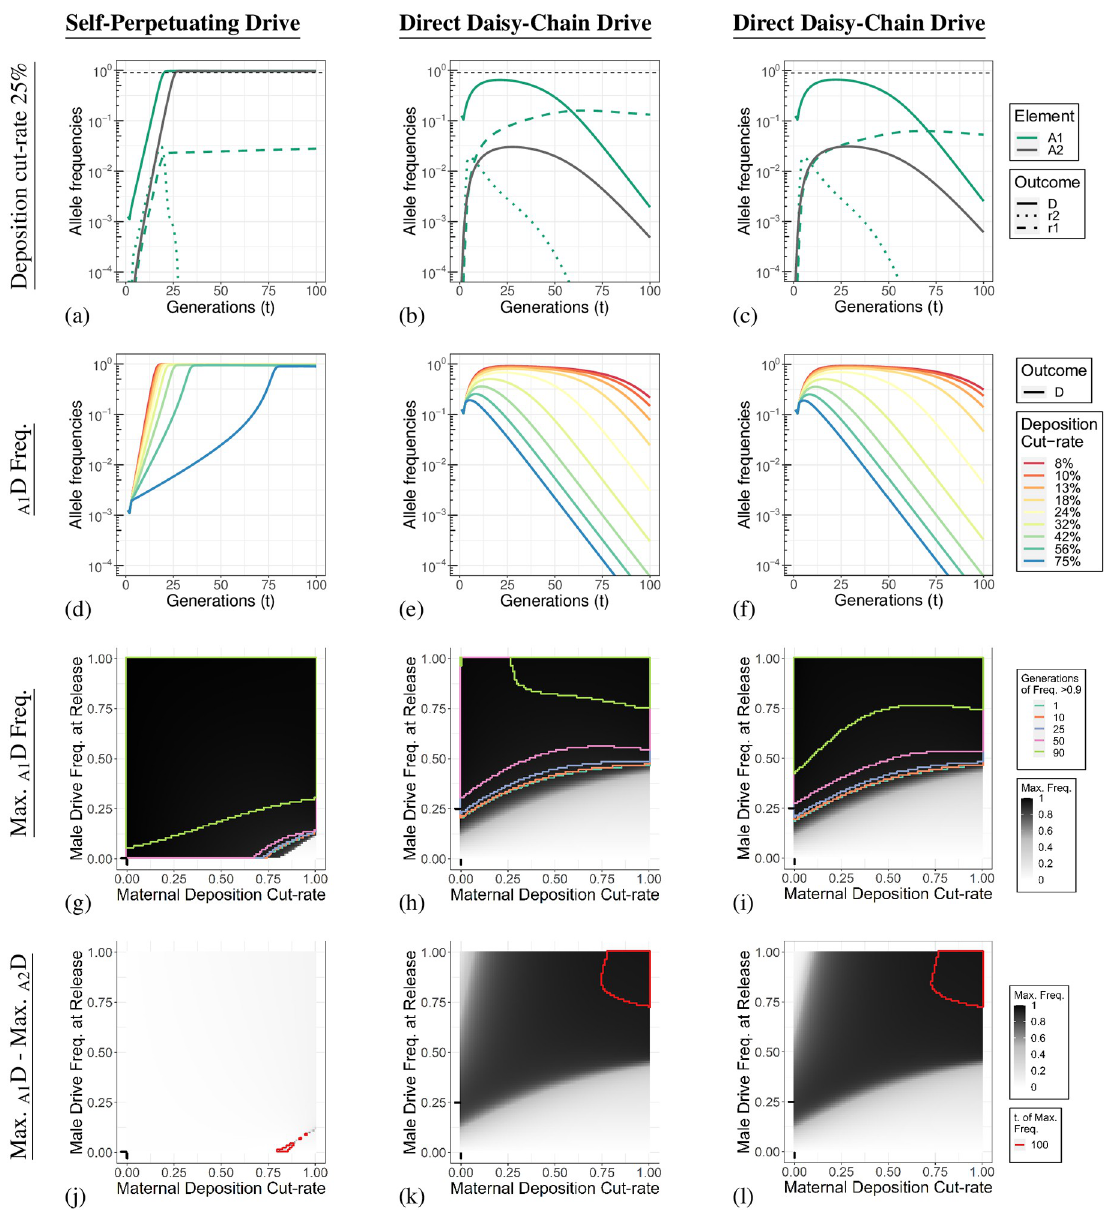
Fig 4. Maternal deposition affects the drives when they are at low frequencies. Column 1 . Self-Perpetuating Drive. Column 2 . Direct Daisy-Chain Drive. Column 3 . Indirect Daisy-Chain Drive. Row 1 (a-c) . Individual allele dynamics with a maternal deposition cut-rate of 25%. The thin dashed line indicates a frequency of 90%. An allele at locus A in population one is indicated by A1 (green lines), and a drive allele at locus A in population two is indicated by A2 (gray line). Type 1 and 2 resistance alleles are not shown for population two in these panels. The allele dynamics for all loci are shown in S14 Fig. Row 2 (d-f) . A locus drive allele dynamics for population one with different maternal deposition cut-rates. Allele dynamics of the A locus drive allele in population two, and type-1 resistance alleles for both populations are shown in S15 Fig. Row 3 (g-i) . Parameter sweep for the male drive frequency at release and maternal deposition rates. The shading of the heat map indicates the maximum A D allele frequency in population one reached within the 100 generations simulated. The maximum frequency of A 1 alleles and outcomes for population two are shown in S18 Fig. An immediate decline after release results in the maximum frequency being the release frequency. Regions are boxed with coloured lines that indicate threshold values for the number of generations in which the A1 D allele frequency was greater than 90%. The black lines on each axis indicate the default value for the parameter being varied. Row 4 (j-l) . Difference in the maximum A D allele frequency between population one and two. Regions boxed with a red line are simulations in which the maximum allele frequency of population one or two was at generation 100 and the outcomes may change if additional generations are